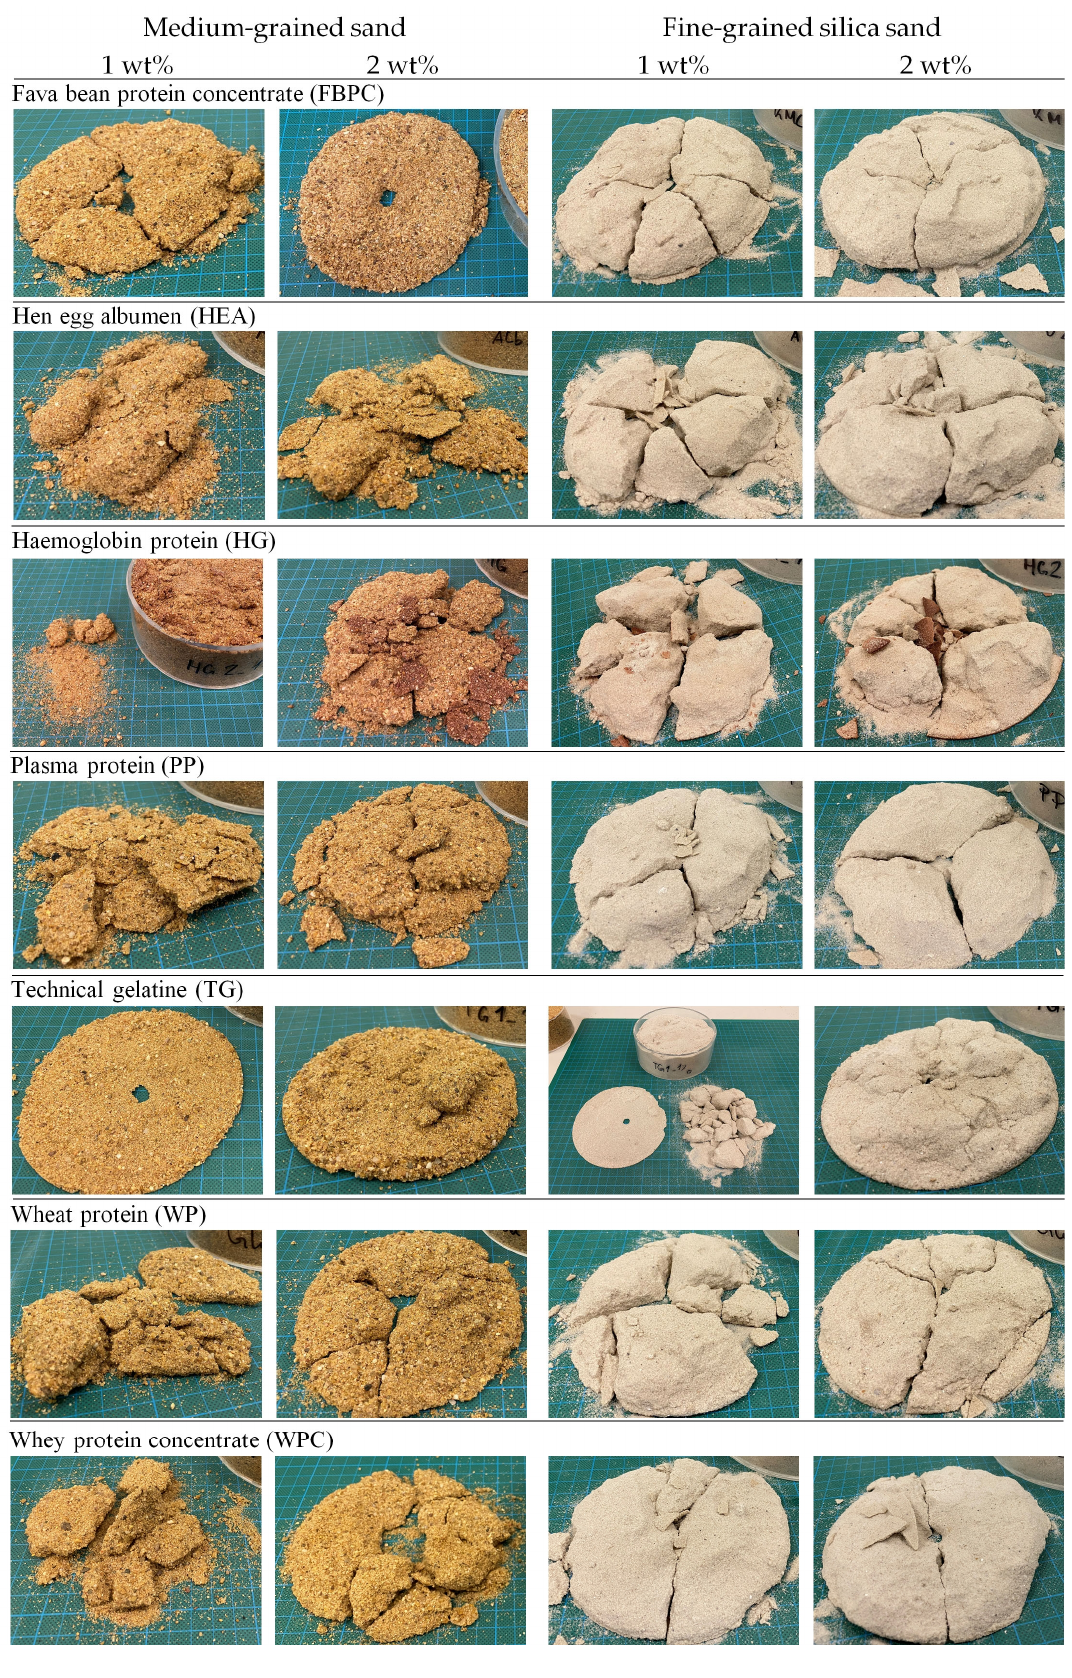
Figure 11. Examples of protein-induced crusts recovered from the samples (cf. Table A6 for classification).